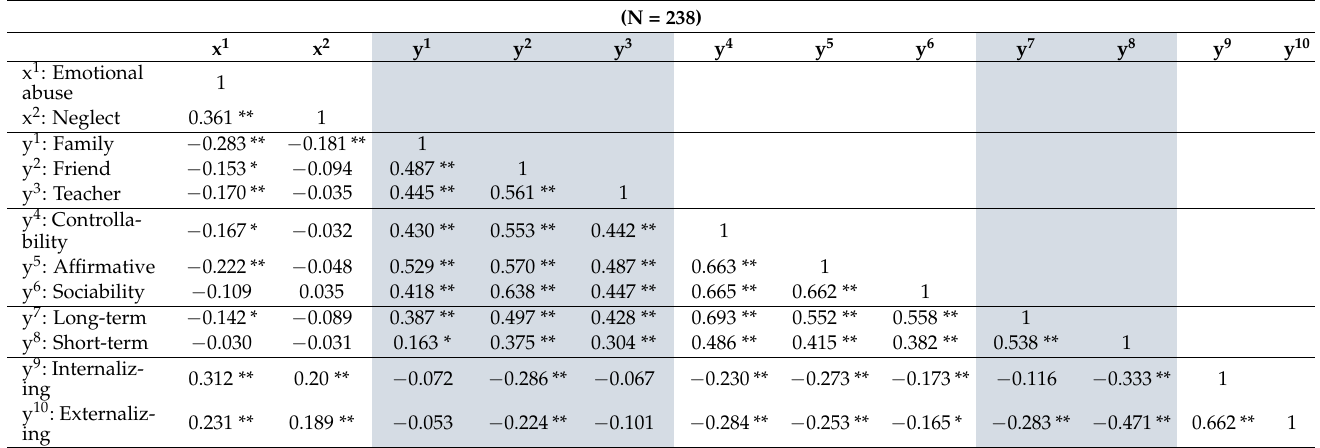
Table 3. Correlations among the Measured Variables.